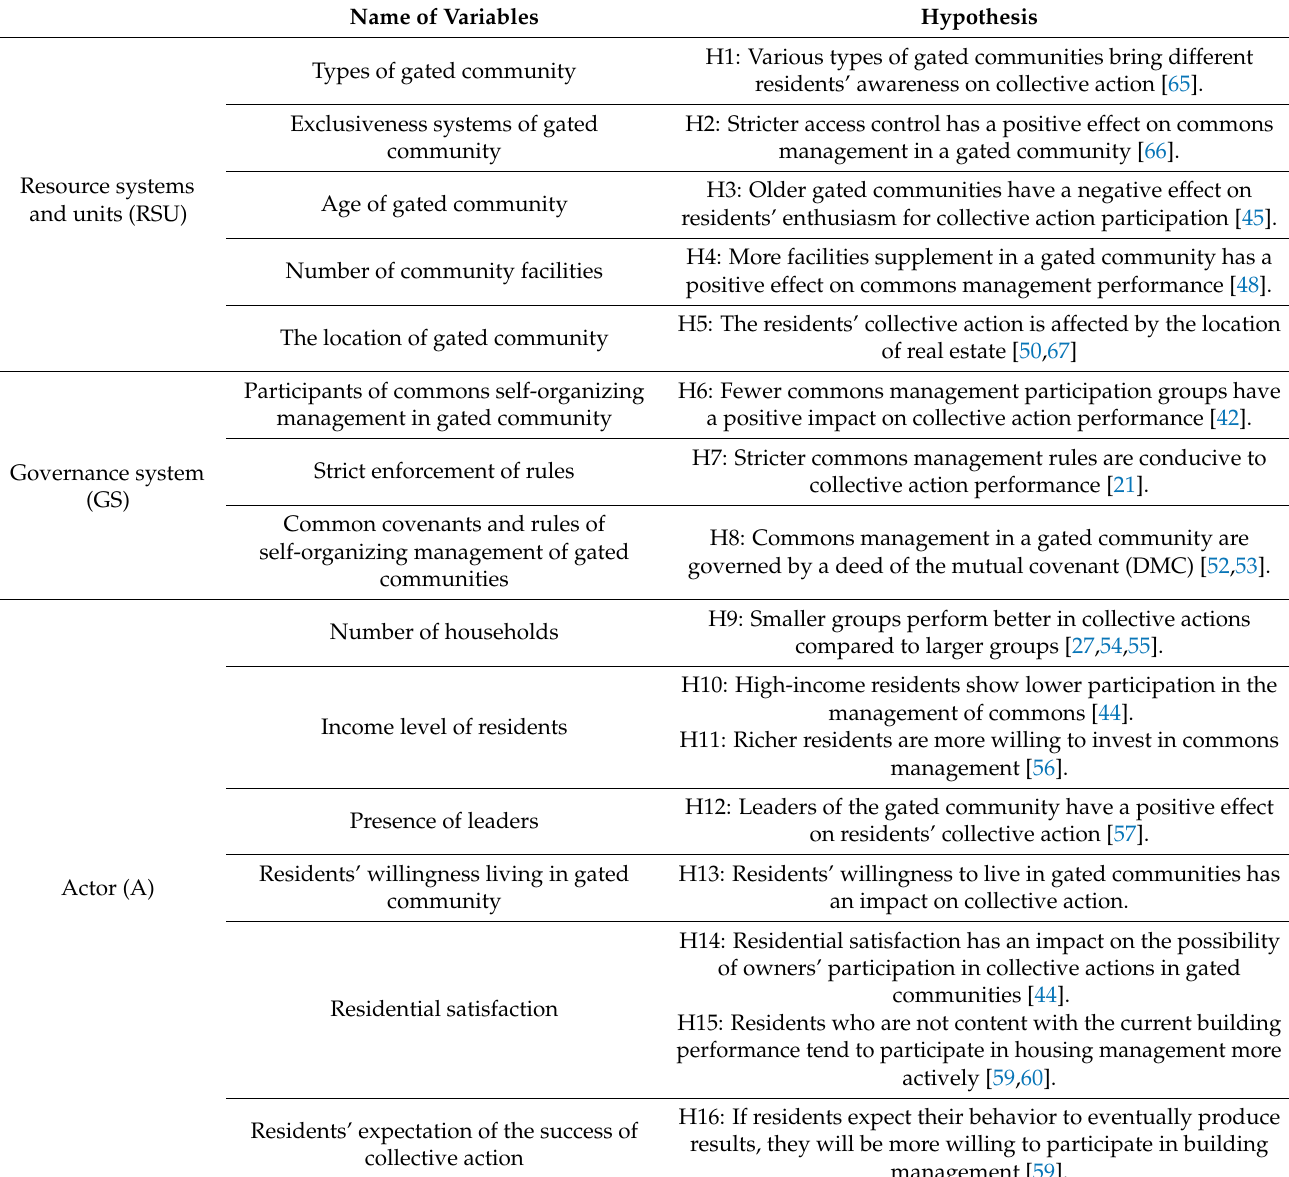
Table 3. Research